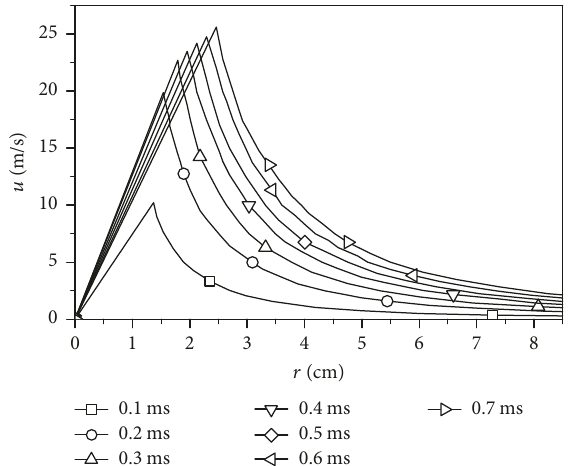
Figure 6: Radial velocity profiles at different times.